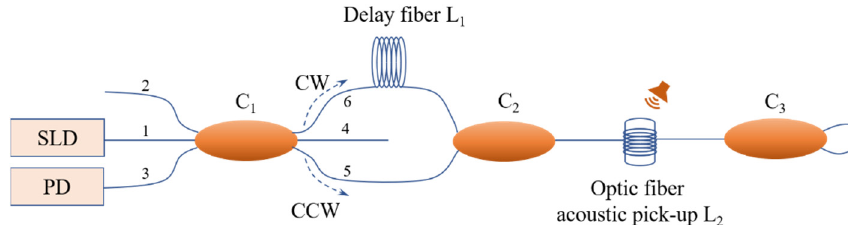
Figure 1. A schematic diagram of traditional Sagnac fiber optic acoustic sensor.